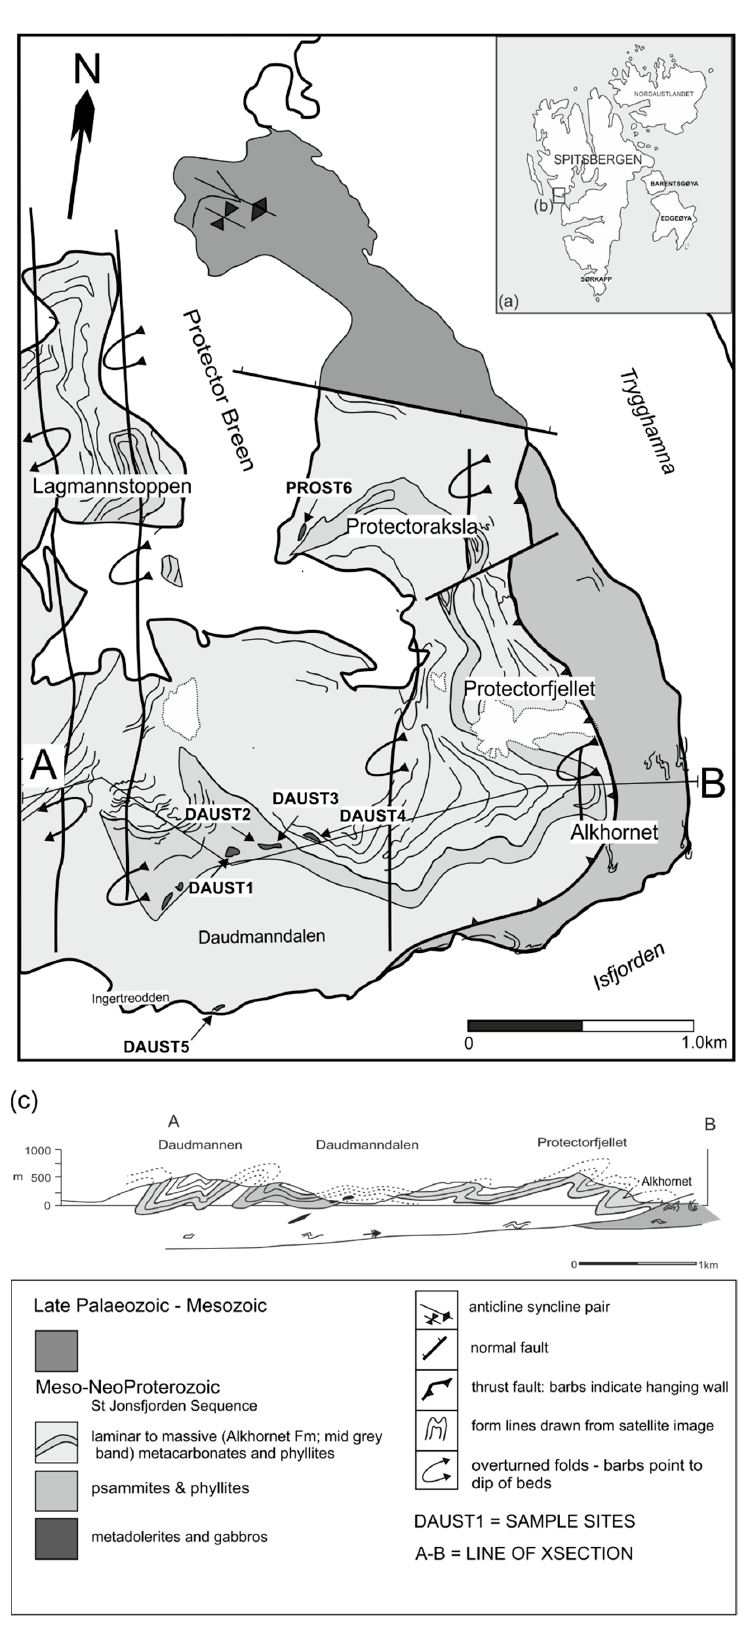
Figure 1. ( a ) Locations of palaeomagnetic sites are given; ( b ) Geological sketch map of SW Oscar II Land; ( c ) Geological cross-section (A–B) across Daudmannen to Alkhornet.